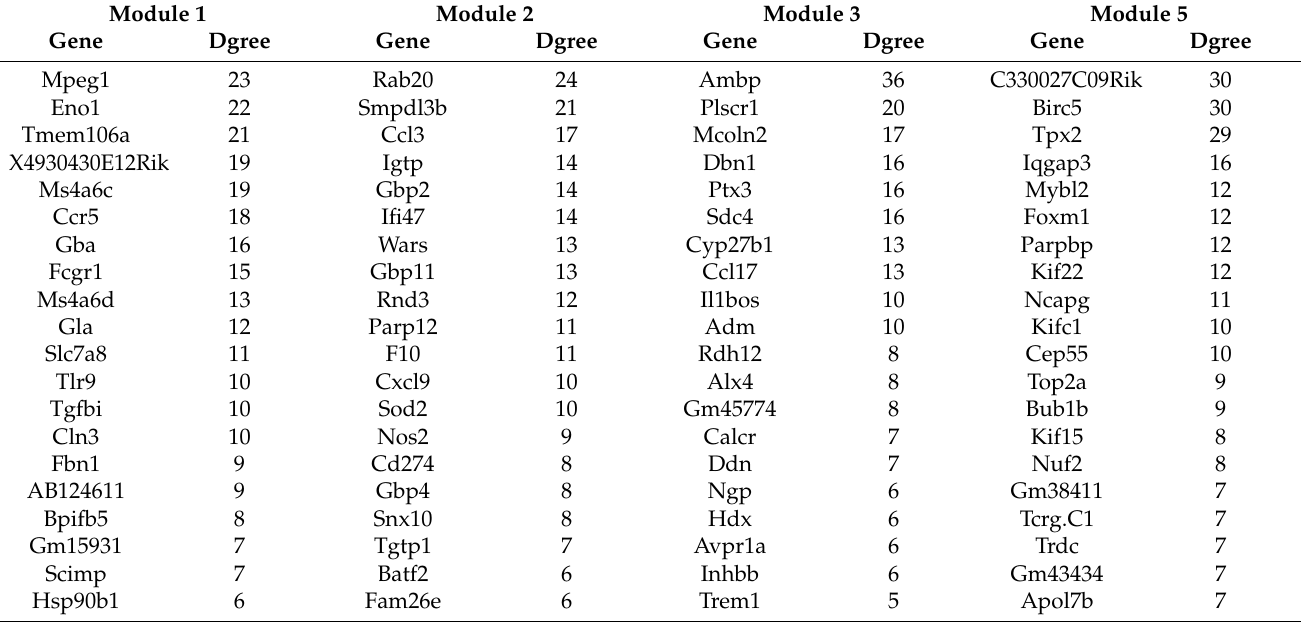
Table 1. Top 20 hub nodes in the progression-related modules were identified by the gene modules in the weighted gene coexpression network analysis